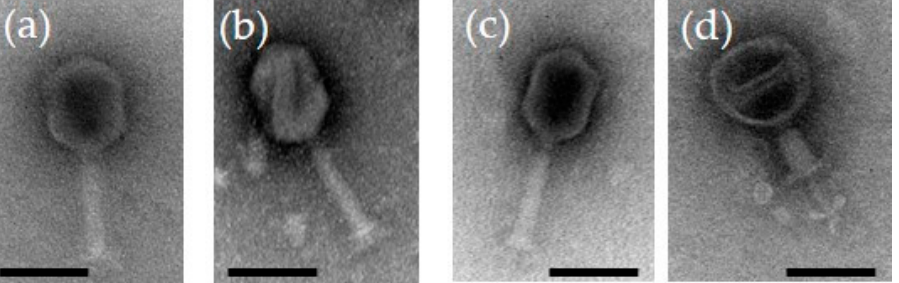
Figure 1. Transmission electron micrographs of negatively stained bacteriophages: ( a ) fPS-2; ( b ) fPS-90; ( c ) fPS-65; ( d ) fPS-65 with a contracted tail. The scale bar is 100 nm.